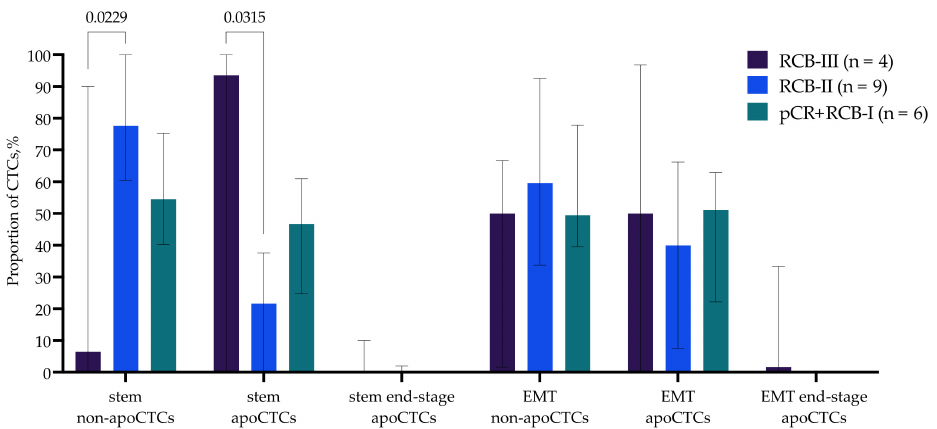
Figure 6. Proportion of CD44+CD24 − CTCs and N-cadh+ CTCs with EMT features in breast cancer patients with different responses to neoadjuvant chemotherapy.